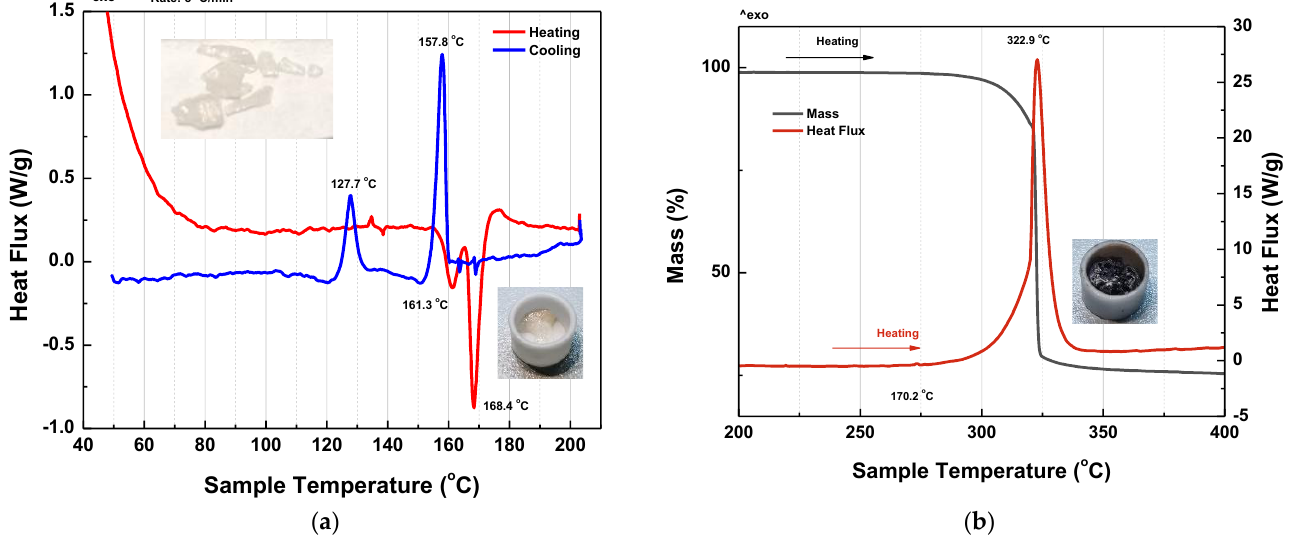
Figure 10. TG-DSC curves for heating and cooling at a rate of 5 °/min of MBI-perchlorate crystals Sample 1 ( a ) DSC curves for heating up to 200 °C. Upper and Lower insets show images of sample before and after heating, respectively. ( b ) TG-DSC curves for heating from 200 °C up to 400 °C. The inset shows the image of sample after heating.